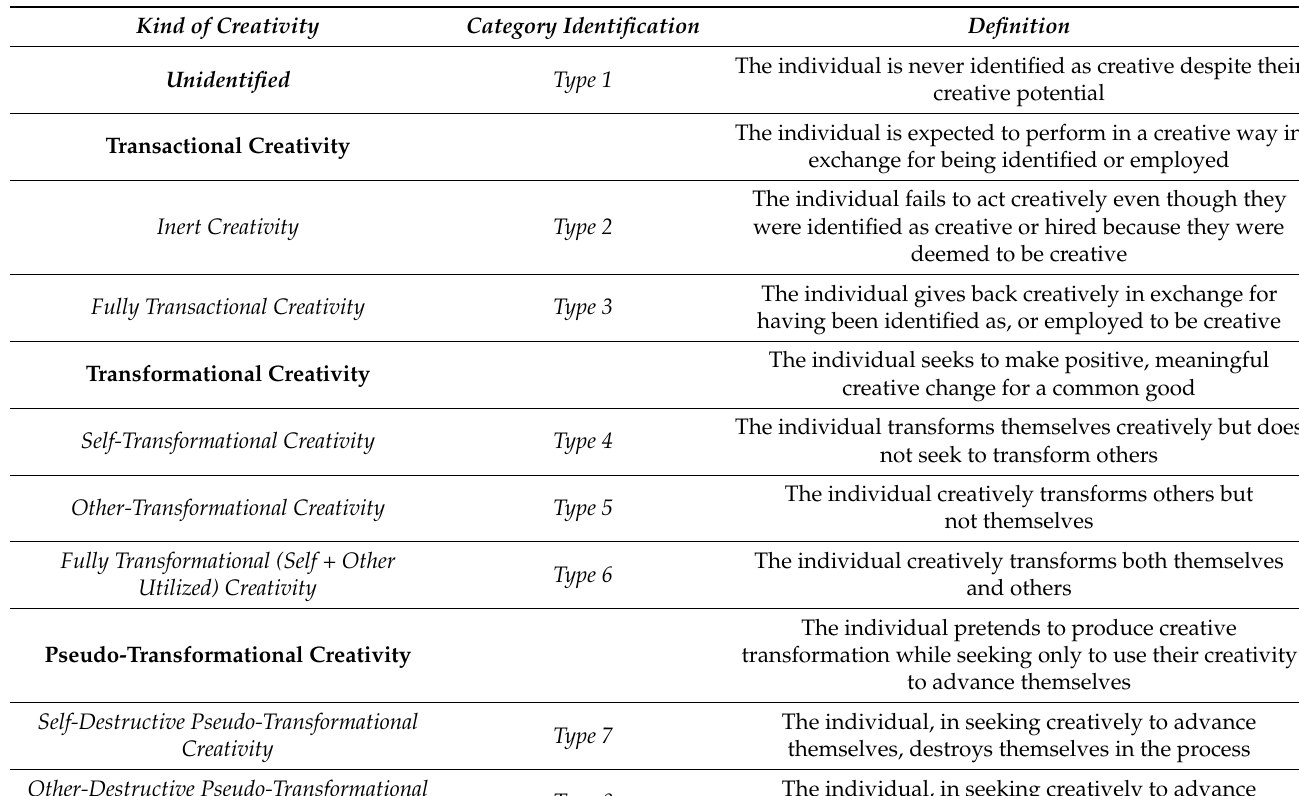
Table 1. Deployment of giftedness: Four categories of utilization of gifts *.